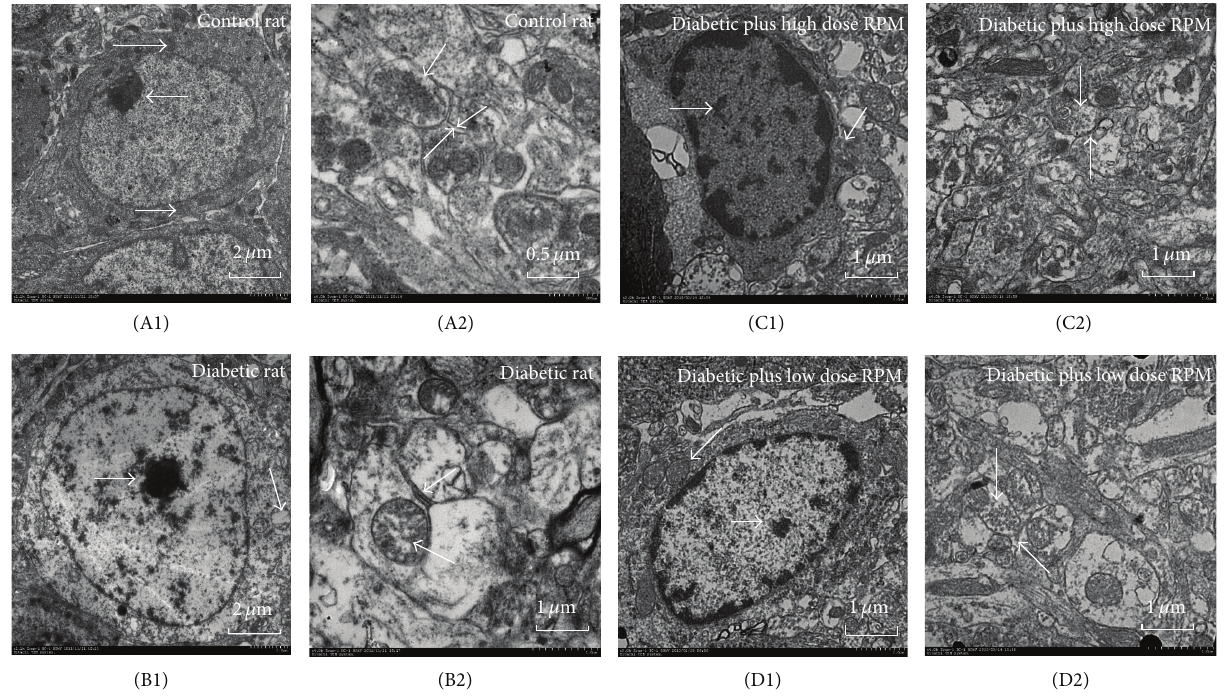
Figure 3: The ultrastructure of neuronal cells (A1, B1, C1, and D1) and synapses (A2, B2, C2, and D2) of hippocampal tissue in rats of each group. A: control rat; B: diabetic rat; C: diabetic plus high dose RPM; D: diabetic plus low dose RPM. Control rats showed regular nuclear morphology (Figure 3(A1)), large number of synapses in complete form, and rich synaptic vesicles (Figure 3(A2)). Nuclear membrane shrinkage was observed in diabetic rats and cell membrane structure was also unclear (Figure 3(B1)). Figure 3(B2) showed significantly reduced number of synapses, abnormal synaptic structure, and blur or missing synaptic cleft. Rat neuronal cell structure in diabetic plus RPM had been greatly improved compared with diabetic rats, in which diabetic plus high dose RPM was significantly higher than of in low dose RPM (Figures 3(C1), 3(D1) 3(C2), and